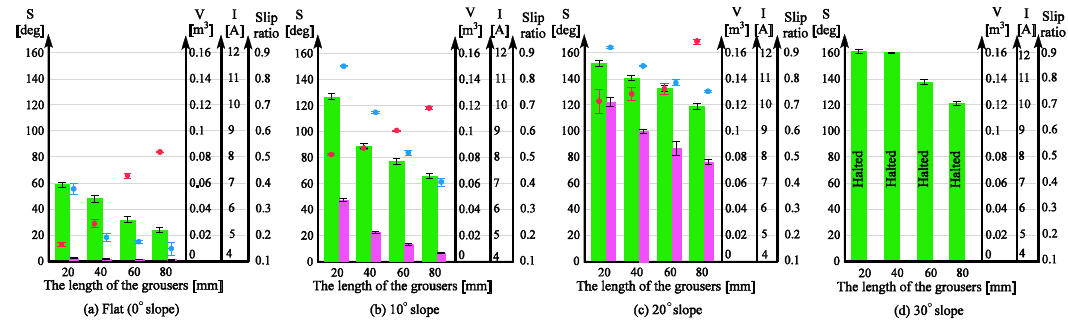
Figure 12. Mobility test results for a conventional wheeled rover on slope inclinations of: ( a ) 0 degrees (level inclination); ( b ) 10 degrees; ( c ) 20 degrees; ( d ) 30 degrees.